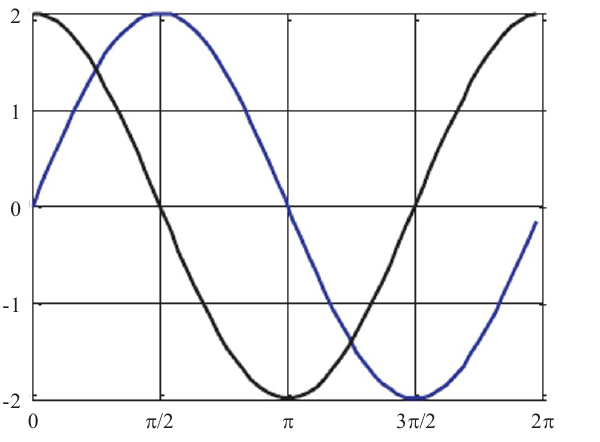
FIG. 2. SINE, COSINE IN RANGE OF [-2,2].